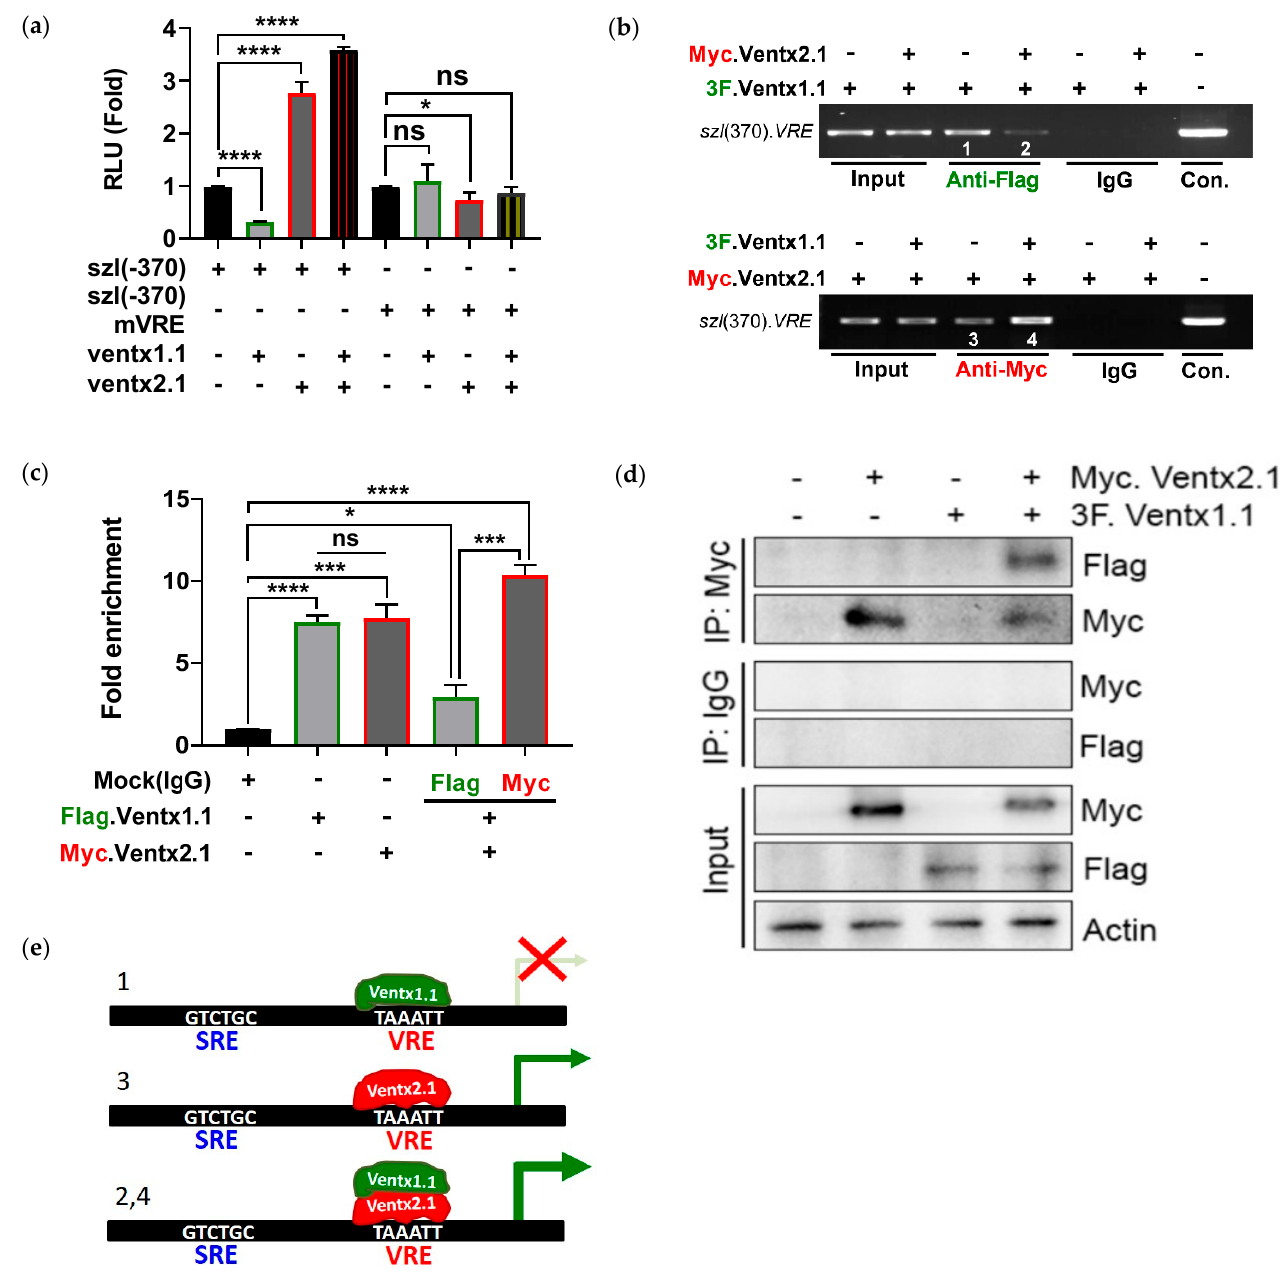
Figure 4. One VRE ( ventx cis-acting response element) site for Ventx1.1/2.1 binding in szl promoter is required for szl transcription: ( a ) Szl(-370) wild type or szl(-370) mVRE were injected with the indicated mRNAs and their combination. Luciferase activities of the samples were analyzed. ( b ) Embryos (300 embryos/sample) were injected alone or with the combination of 3flag-ventx1.1 and myc-ventx2.1 mRNAs (1 ng/embryo) and cultured to the gastrula stage. ChIP-PCR analysis using specific primers for szl promoter region having the VRE site was performed. ( c ) Graph represents the relative band intensities of ChIP-PCR bands. ( a , c ) p ≤ 0.05 for *, p ≤ 0.001 for ***, p ≤ 0.0001 for ****, ns (non-significant) were the assignments for significance. ( d ) Immunoprecipitation assay were performed for 3F.Ventx1.1 and Myc.Ventx2.1 protein-protein interaction during szl promoter binding. (30 embryos/sample) ( e ) A model of Ventx1.1/2.1 alone and combination mediated regulation of szl transcription. The numbers indicate the number of lane shown on ( e ), indicating that each schematic model diagram is related with and based on the result(s) of lane(s) shown on ( b ).